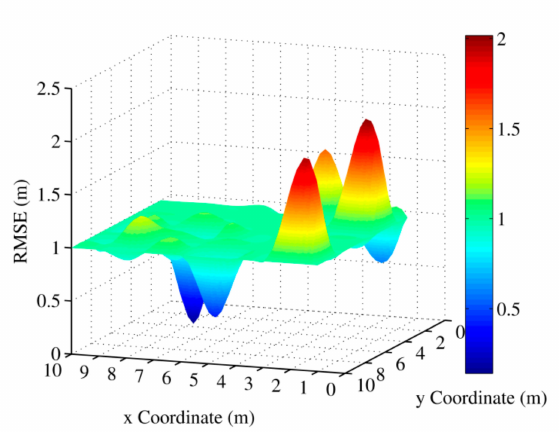
Figure 2. The root-mean-square errors (RMSEs) of OMCT in di ff erent